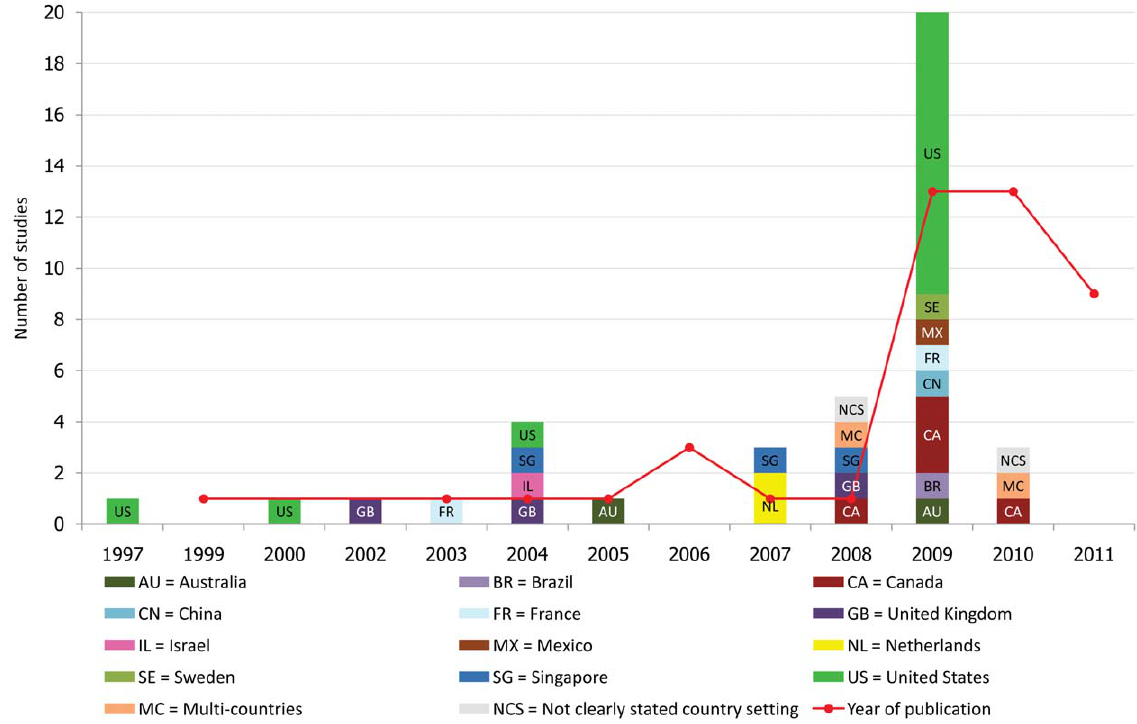
Figure 2. Study setting by year of study and year of publication.